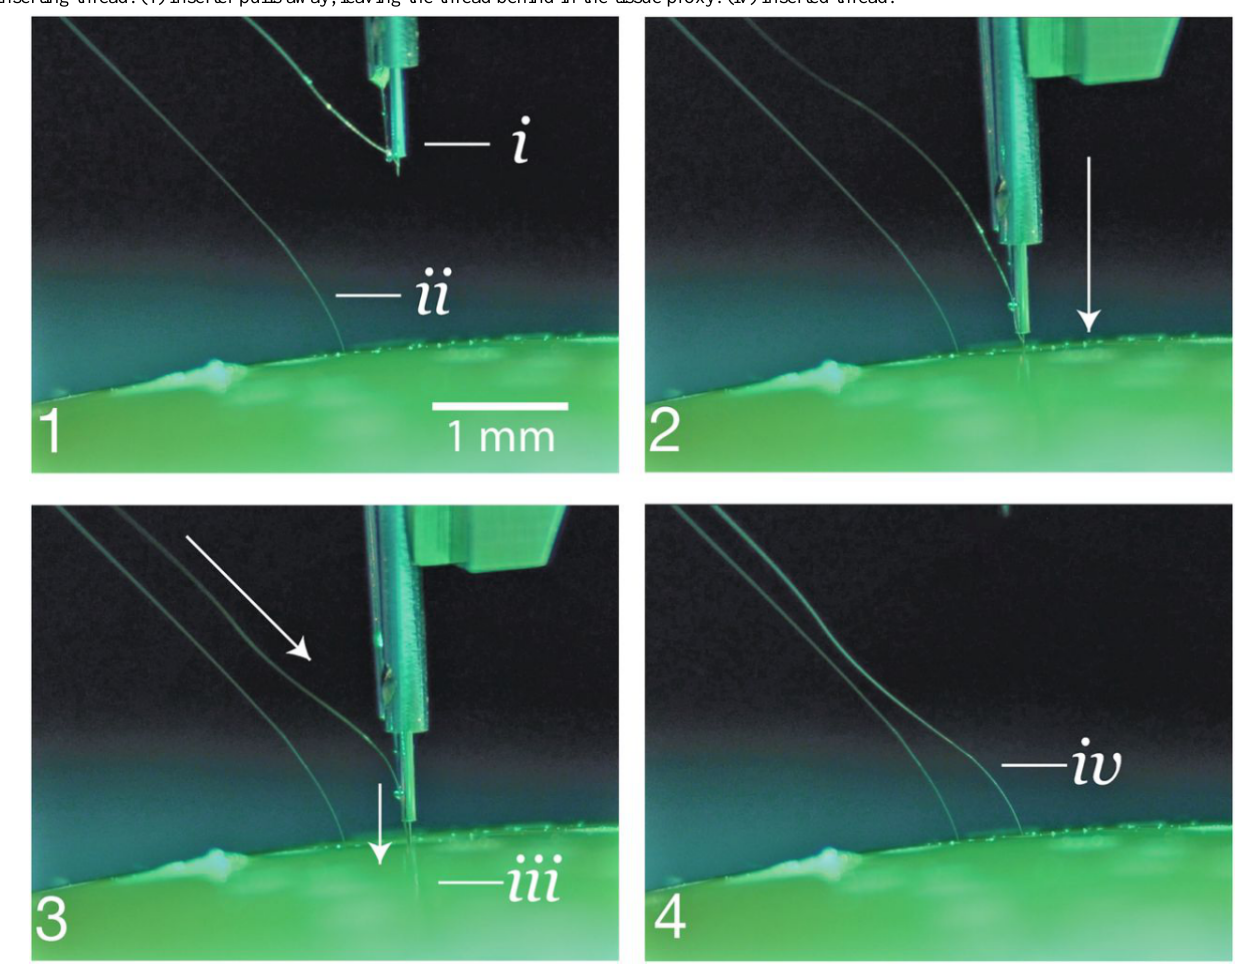
Figure 3. Insertion process into an agarose brain proxy. (1) The inserter approaches the brain proxy with a thread. (i) needle and cannula. (ii) Previously inserted thread. (2) Inserter touches down on the brain proxy surface. (3) Needle penetrates tissue proxy, advancing the thread to the desired depth. (iii) Inserting thread. (4) Inserter pulls away, leaving the thread behind in the tissue proxy. (iv) Inserted